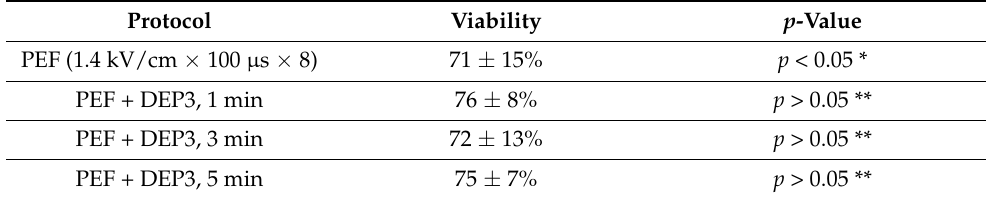
Table 2. Viability of the cells evaluated using 7-AAD